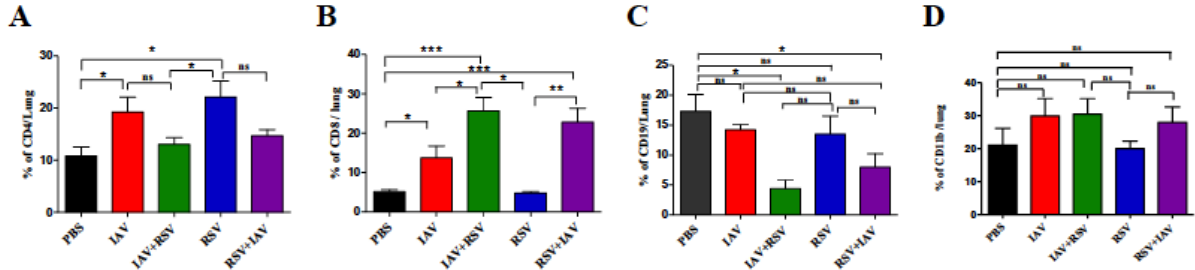
Figure 5. The effects of co-infection on immune-cell populations in the lungs. On day 7 post-infection, mice were sacrificed, and lung immune cells were stained with anti-CD4 ( A ), anti-CD8 ( B ), anti-CD19 ( C ) and anti-CD11B ( D ) antibodies and analyzed by flow cytometry. Results represent mean pooled values +/ − SEM from two independent experiments. Asterisks denote significant differences among the control, co-infected and singly-infected groups (* p < 0.05, ** p < 0.005, *** p < 0.0005); ns = not significant. Comparison among groups was performed using the nonparametric test (two independent variables: Mann – Whitney).